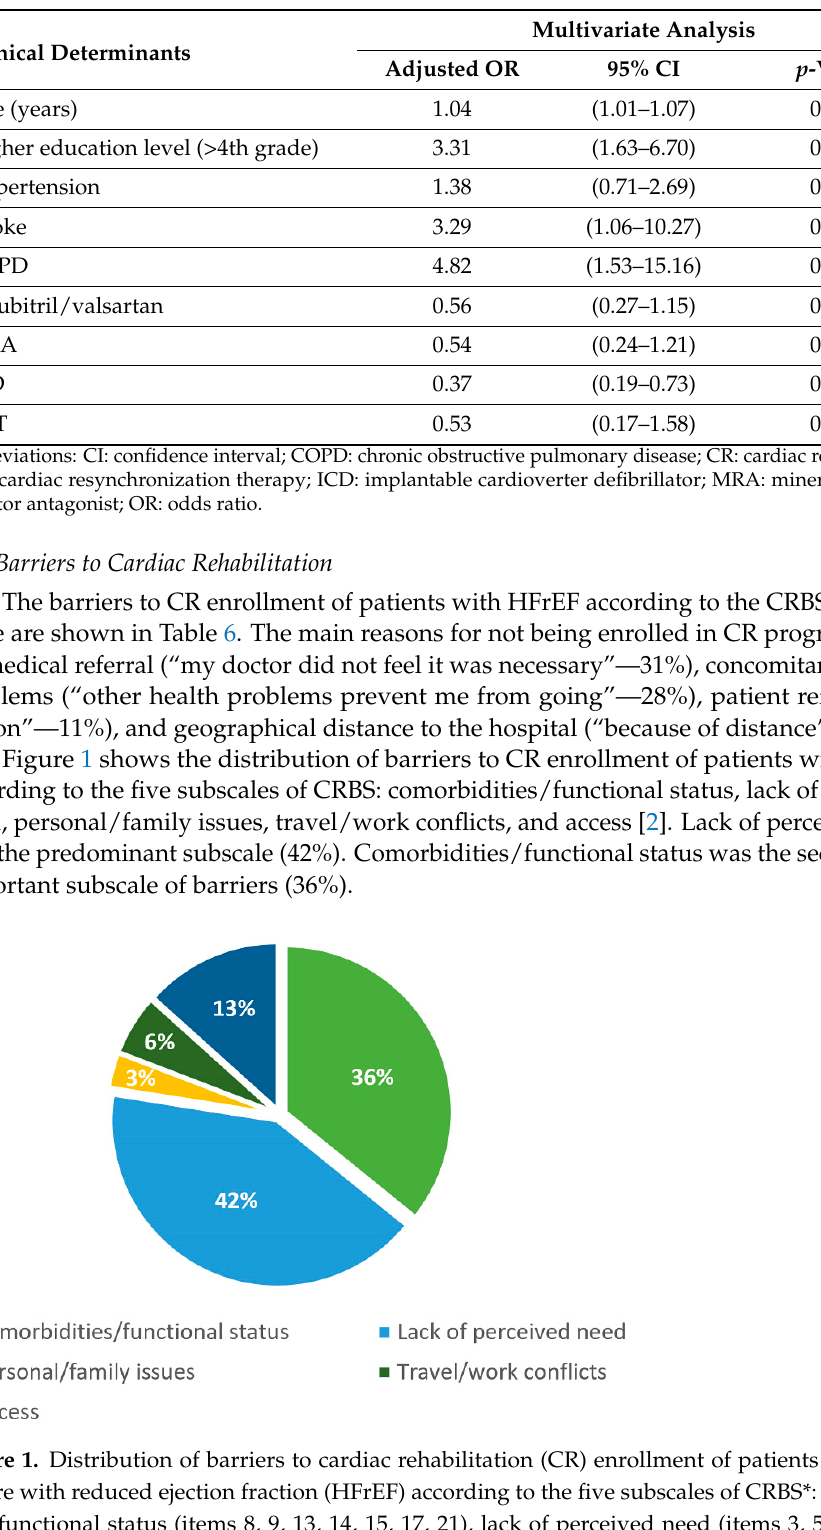
Table 5. Clinical determinants of non-enrollment in a CR program of patients with heart failure with reduced ejection fraction—multivariate analysis and respective adjusted odds ratio (OR).